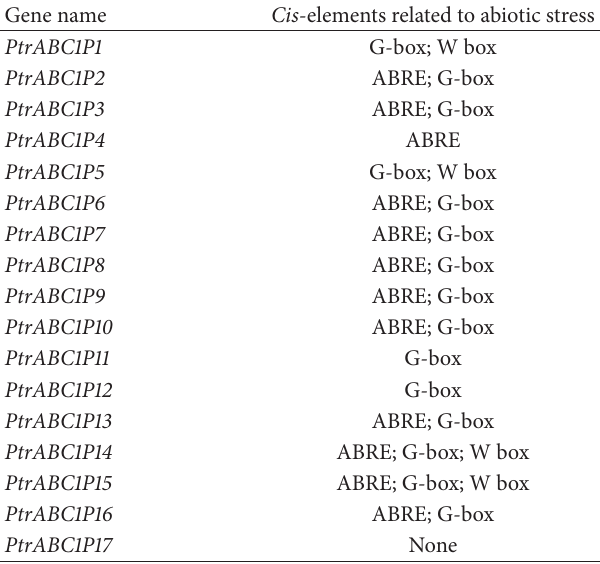
Table 3: Cis -elements of the 17 ABC1 genes related to abiotic stresses such as drought and ABA. These cis -elements were obtained from the Plant Care database (http://bioinformatics.psb.ugent.be/